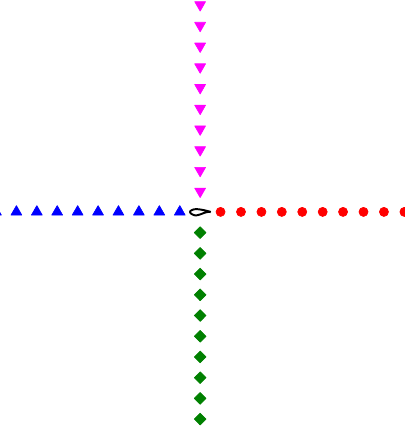
Figure 17. The noise monitoring points in four radial directions of the airfoils.